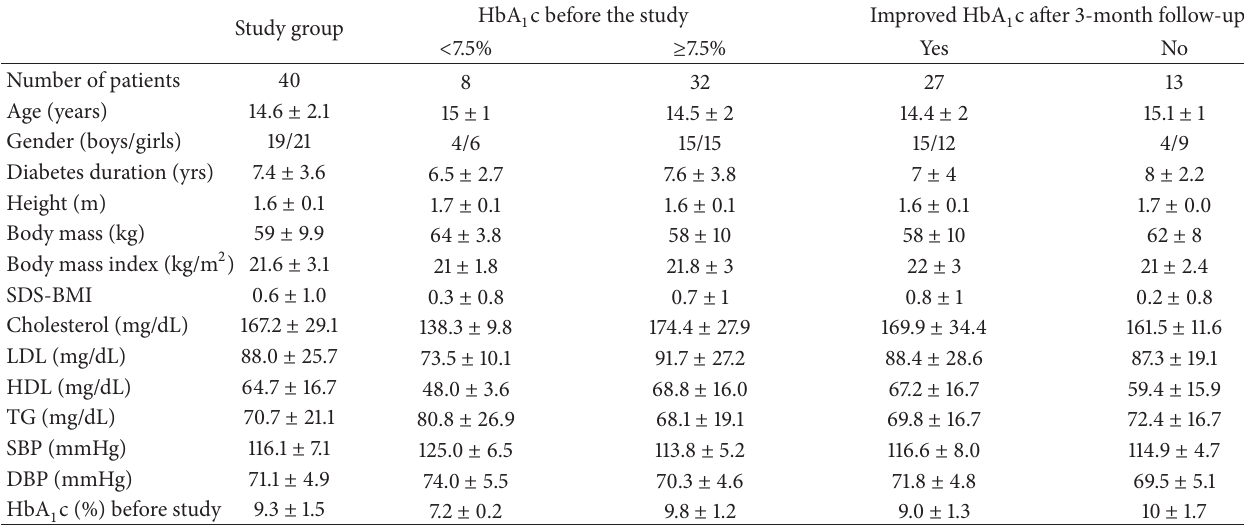
Table 1: Basic characteristic of the study